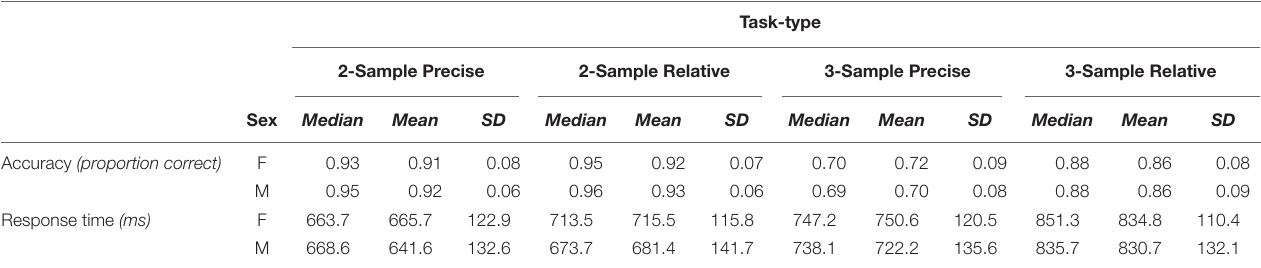
TABLE 1 | Measures of central tendency—medians, means, and standard deviations (SD)—in task performance by group: Females (F) and Males (M), shown for each